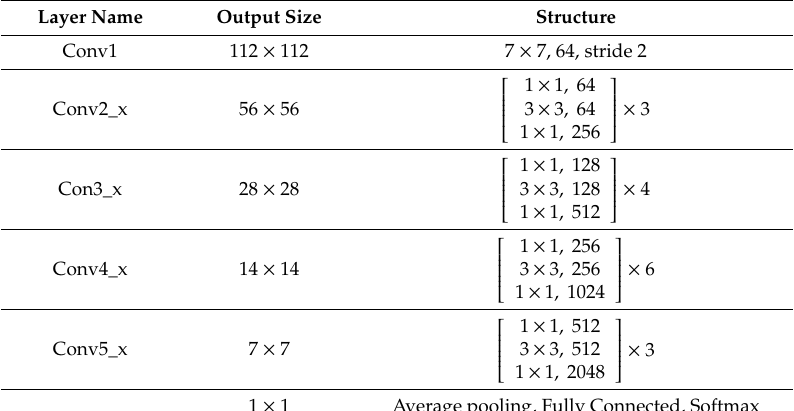
Table 1. The structures of the ResNet-50 model.